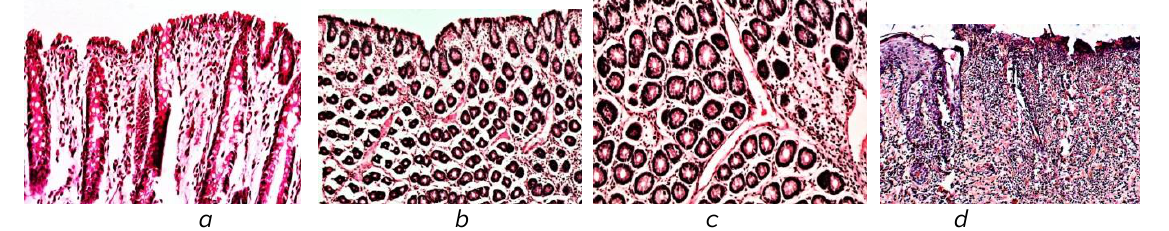
Fig. 4. Proximal wall of the rectal of the rat for 5 days after modeling of experimental hemorrhoids, stained with